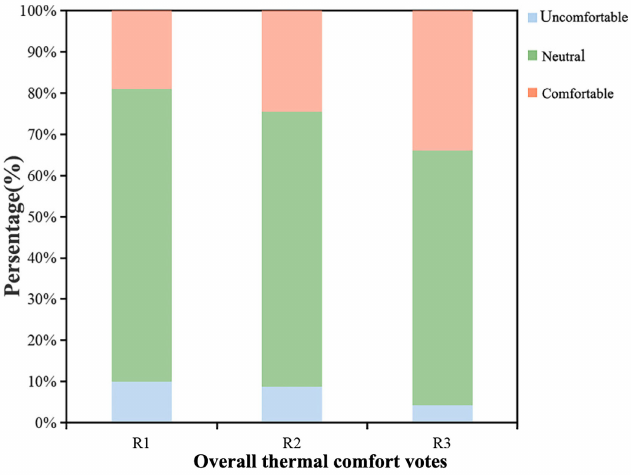
Figure 7. Overall thermal comfort votes (OTCV) in three different measuring sites.